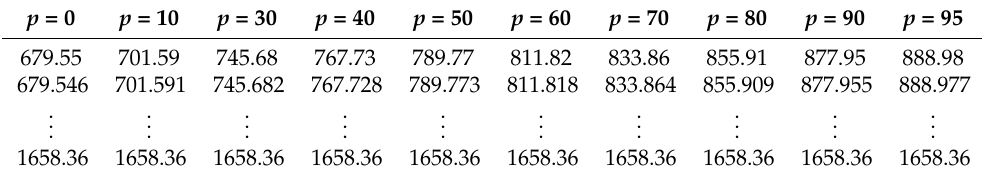
Table 5. Matching data with different p (partial